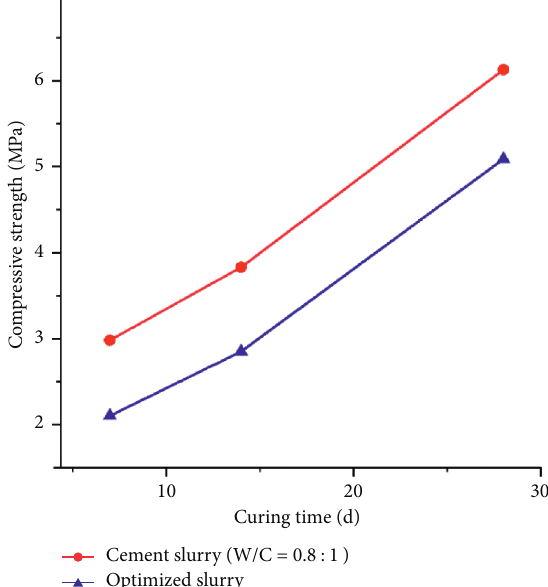
Figure 5: Comparison of strength between pure cement slurry and optimized slurry in different